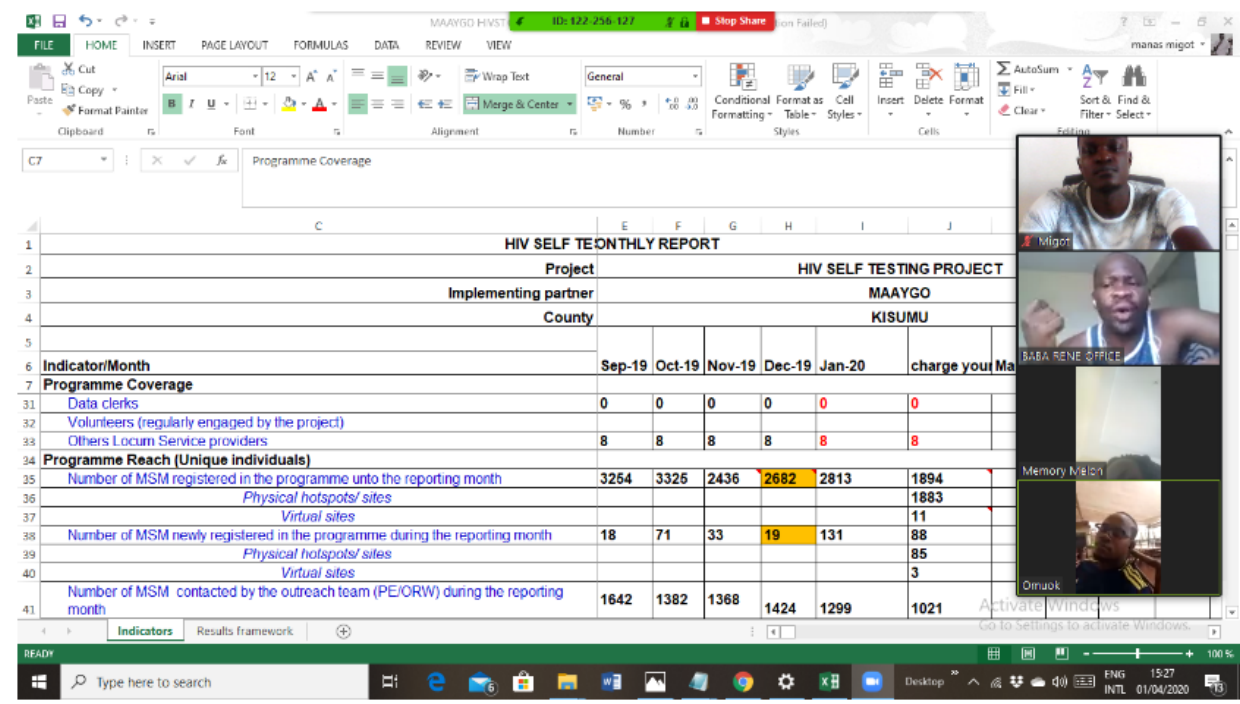
Figure 10. MAAYGO staff and outreach workers evaluating project implementation